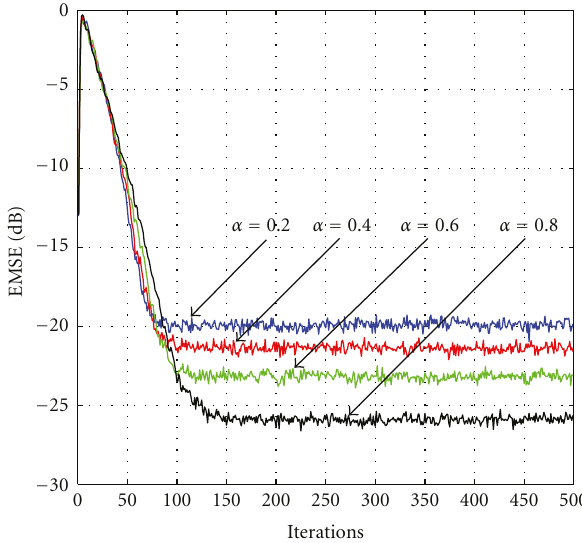
Figure 4: E ff ect of α on the learning curves of the proposed algorithm in a uniform noise environment scenario for p = 1.